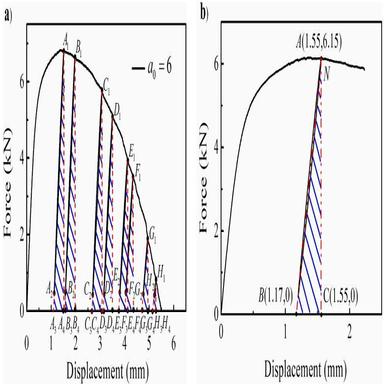
(a) The load–displacement curve of the U-notch with the initial length a0 = 6 in crack propagation experiment; (b) The load–displacement curve of the U-notch with the initial length a0 = 8 mm in crack initiation experiment.